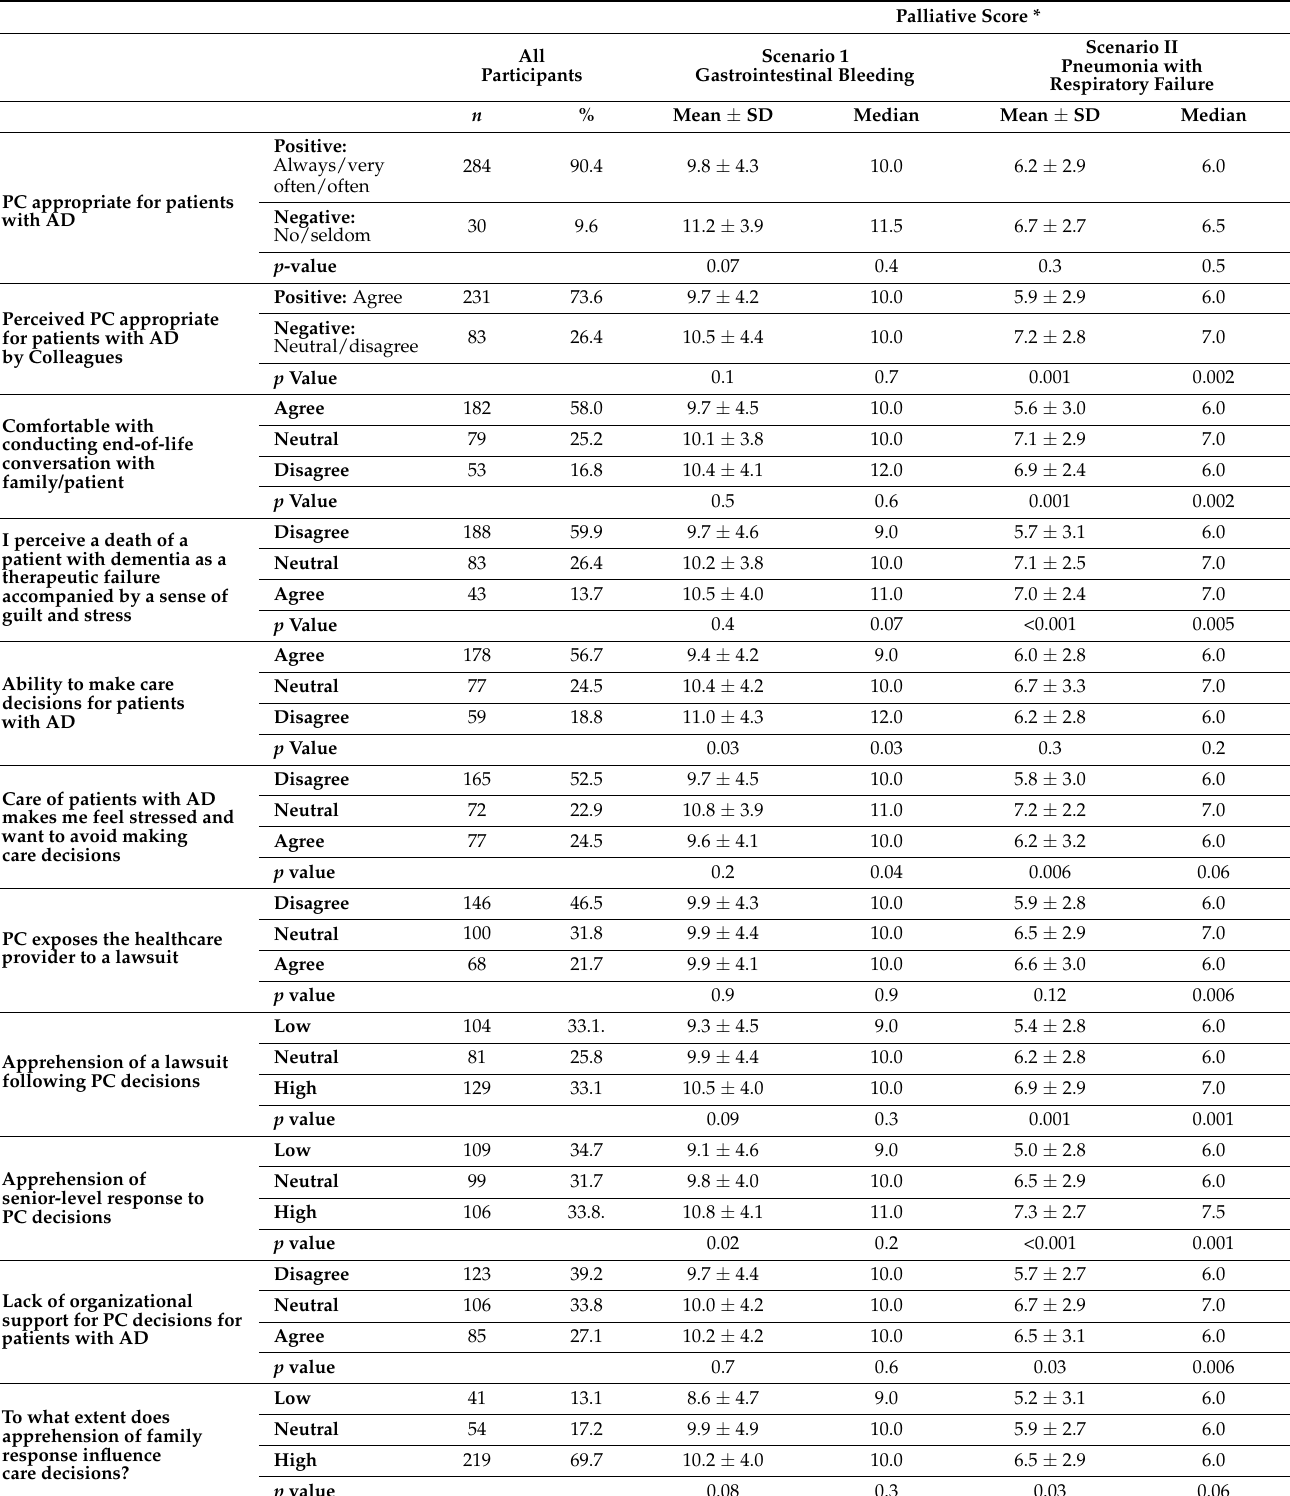
Table 4. Association between palliative care perceptions and treatment approach in the two hypo- thetical scenarios ( n =